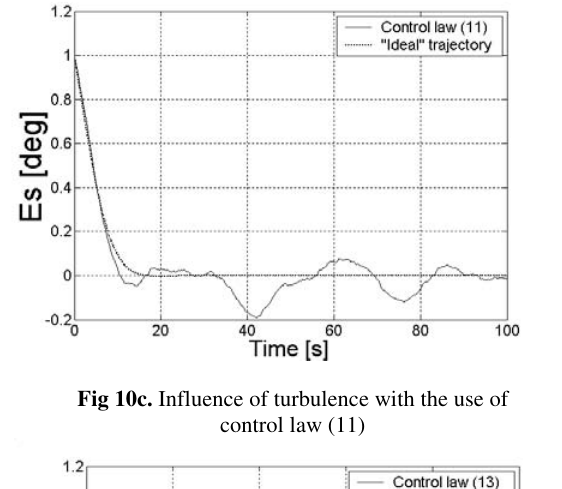
Fig 10c. Influence of turbulence with the use of control law (11)